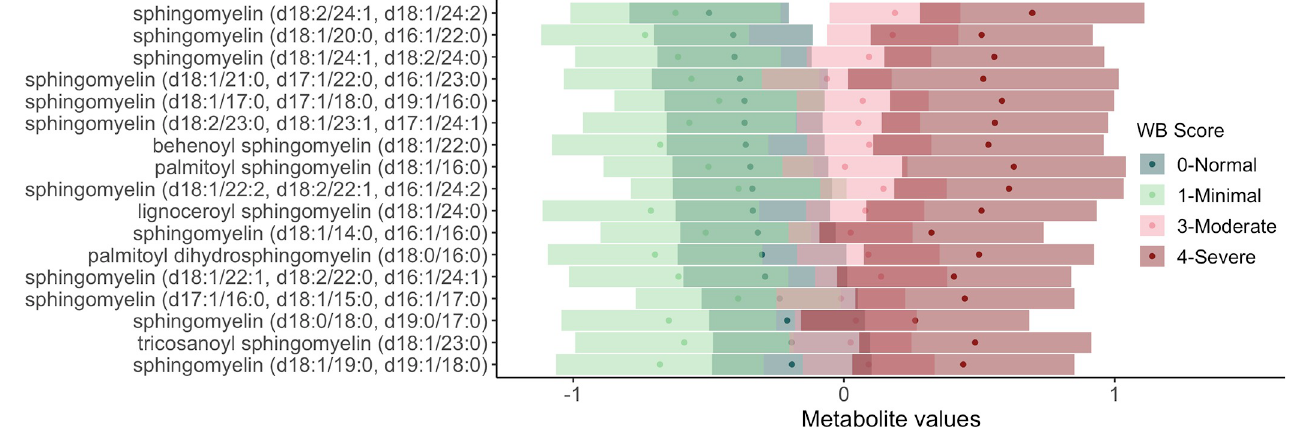
Fig 5. Association of wooden breast score with sphingolipid metabolism in plasma of male broiler chickens. Results of post-hoc analysis of metabolite values by wooden breast score are shown with estimated marginal means (dots) and confidence intervals (bars). Overlapping confidence intervals indicate that there is no significant difference between the two scores. To improve visualization, metabolites are listed in order of the adjusted means for a wooden breast score of 0-Normal.